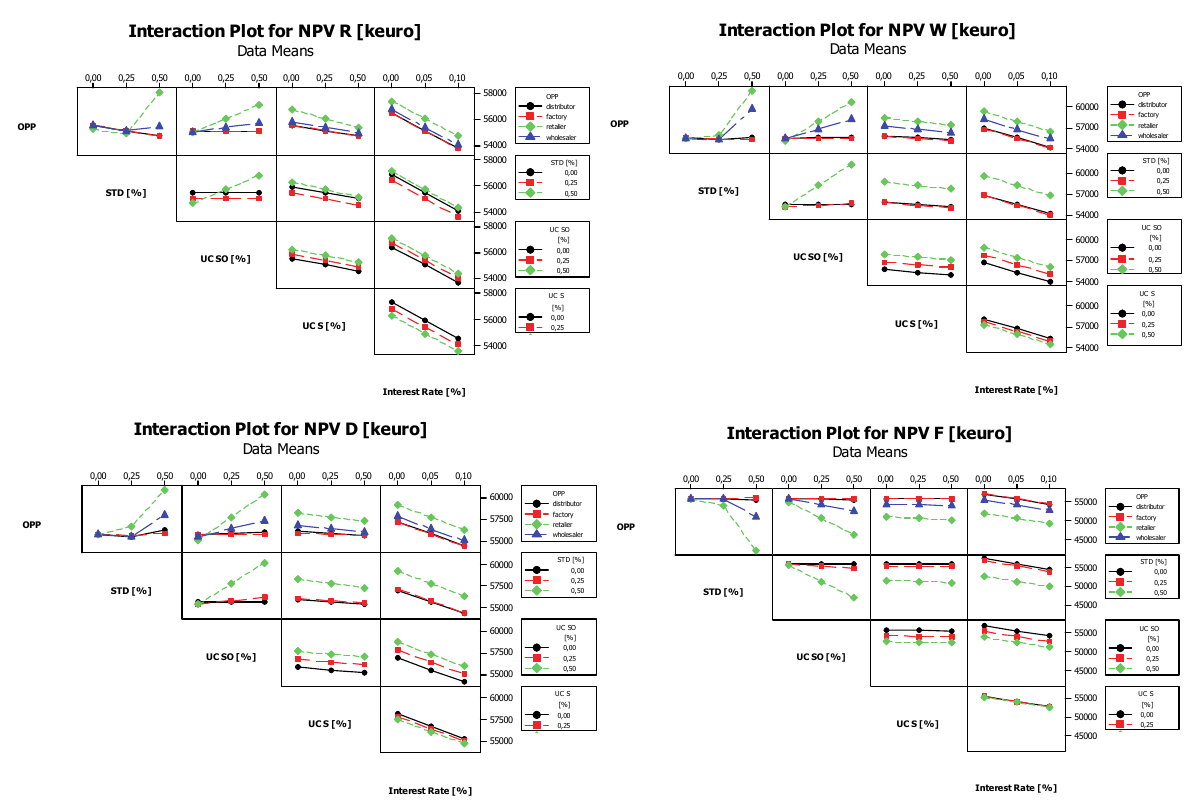
Fig. 2. Interaction Plot of main factors for NPV performances in DECENTRALIZED CONTROL